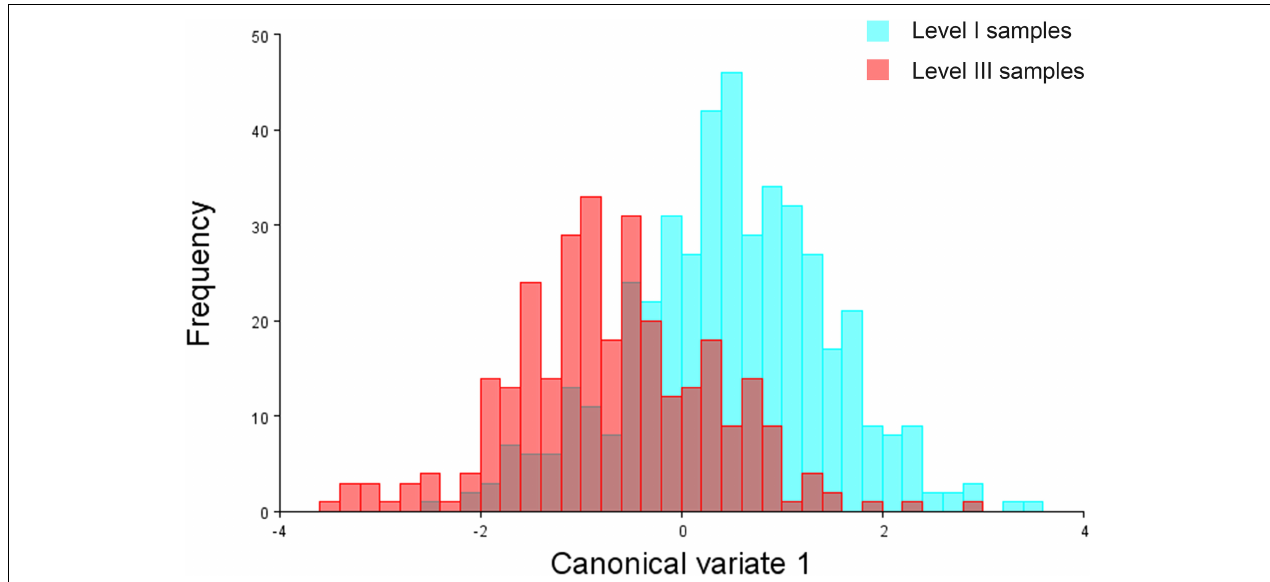
FIGURE 4 | Canonical variable frequency bar chart of Levels I and III